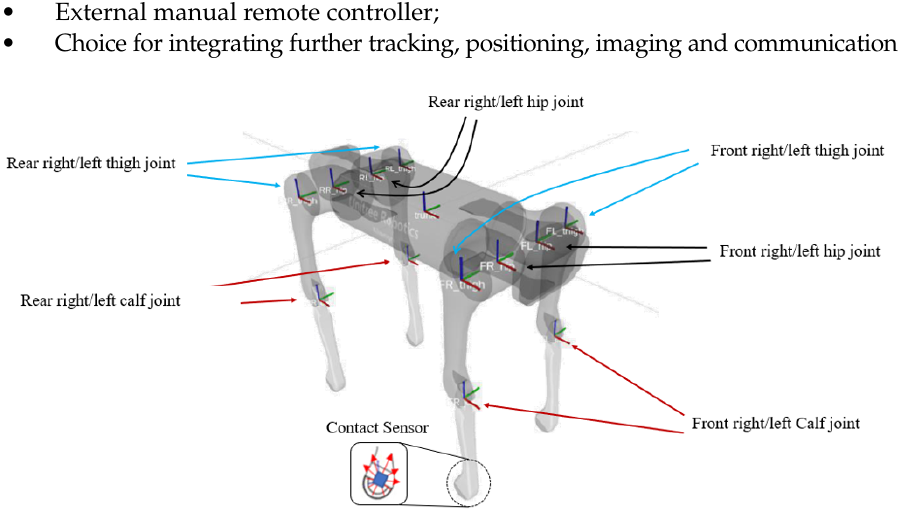
Figure 2. Body joints on the quadruped robots to achieve locomotion.